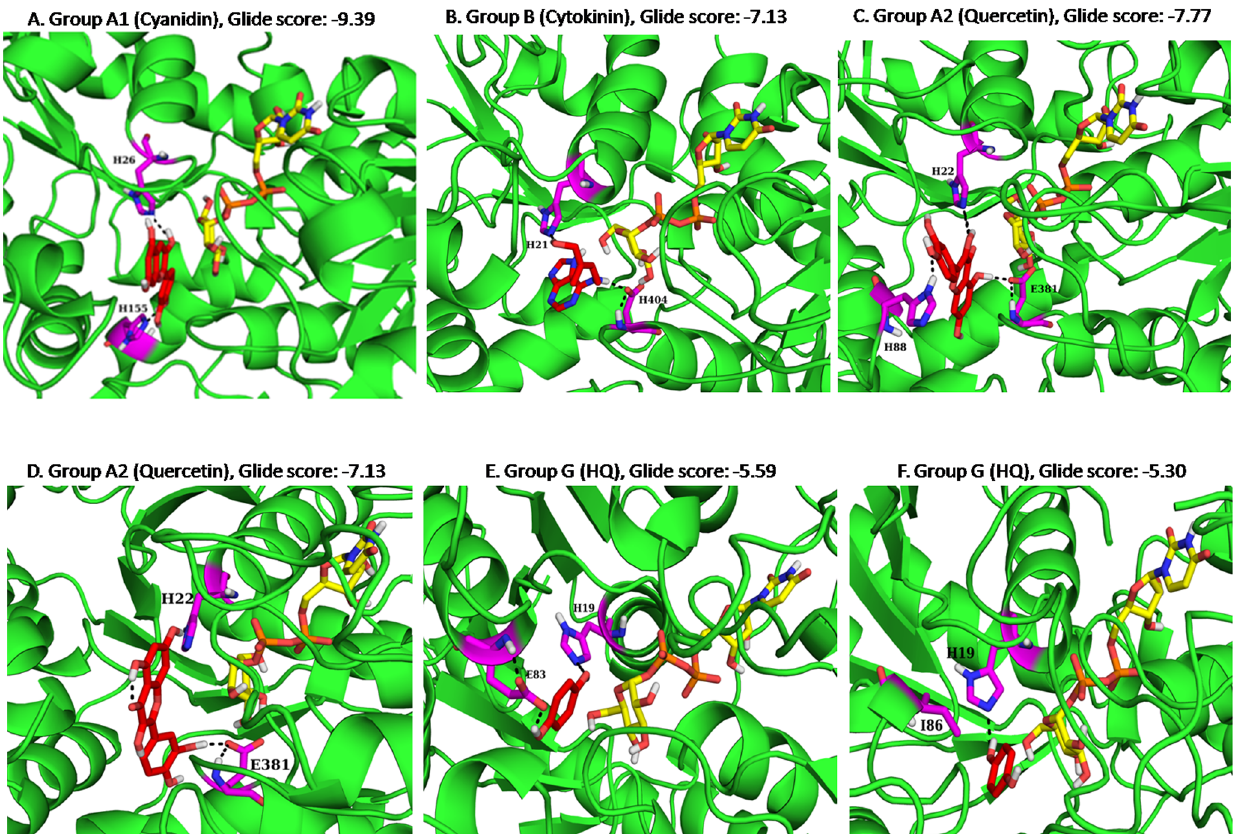
Figure 5. Docked complexes of Ca UGTs with their respective acceptor and sugar donor. A. The docked complex of Ca UGT of group A1 with cyanidin (shown in stick form) interacting with H26 and H155. B. The docked complex of Ca UGT of group B with cytokinin (shown in stick form) interacting with H21 and H404. C. The docked complex of Ca UGT of group A2 in which 3-OH group of quercetin (shown in stick form) interacting with H22. D. The docked complex of Ca UGT of group A2 in which 7-OH group of quercetin (shown in stick form) is pointing towards H22. E. The docked complex of Ca UGT of group E with hydroquinone (shown in stick form) interacting with H19 and E83 shown in stick form. F. The docked complex of Ca UGT of group G with hydroquinone (shown in stick form) interacting with